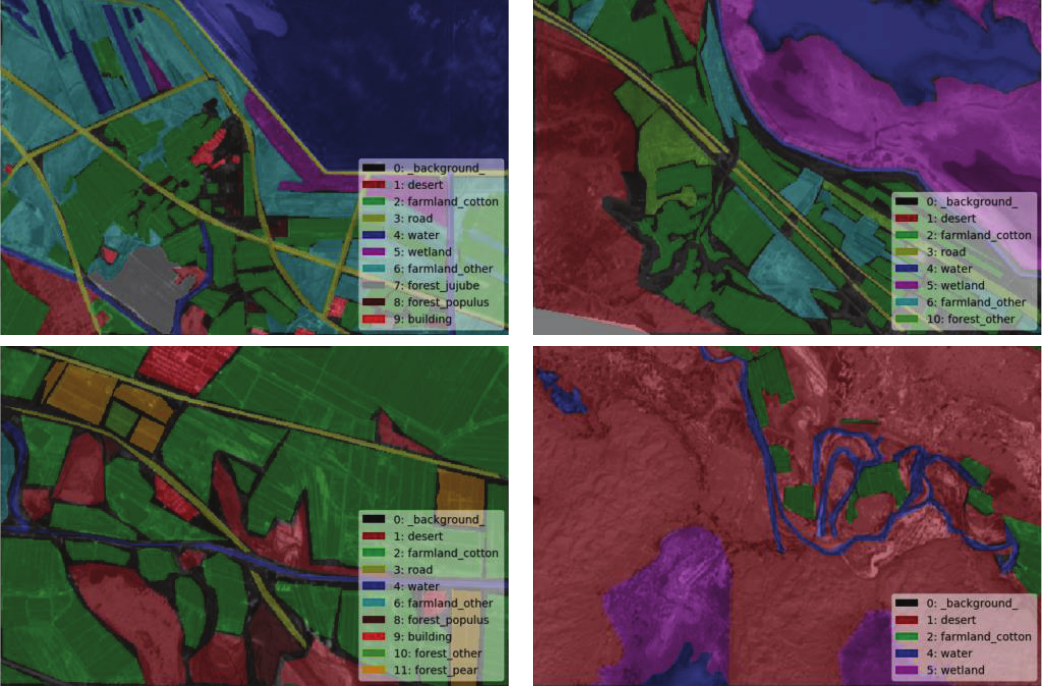
Figure 3. Partial Annotation